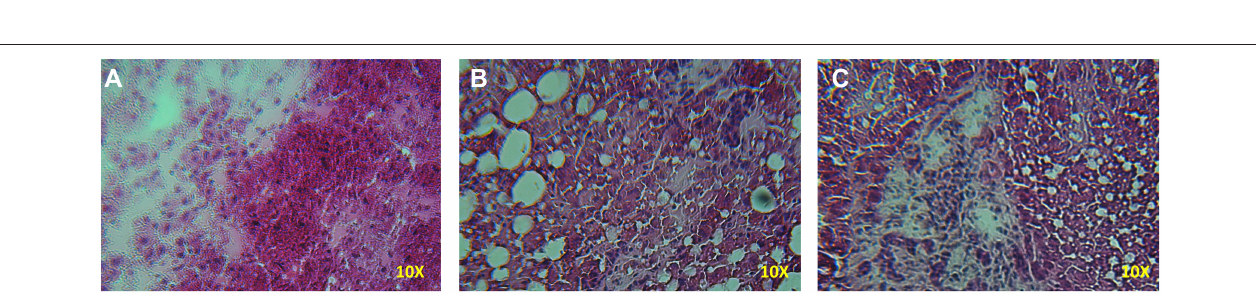
FIGURE 2 | Histopathology of the liver samples stained with HE from rats treated with D-galactosamine and D-galactosamine + DHEA for 48h. (A) Normal control group with proper architecture of the liver, (B) D-galactosamine-induced hepatotoxicity characterized by marked steatosis and hepatocyte degeneration, and (C) D-galactosamine + DHEA with steatosis and altered parenchymal